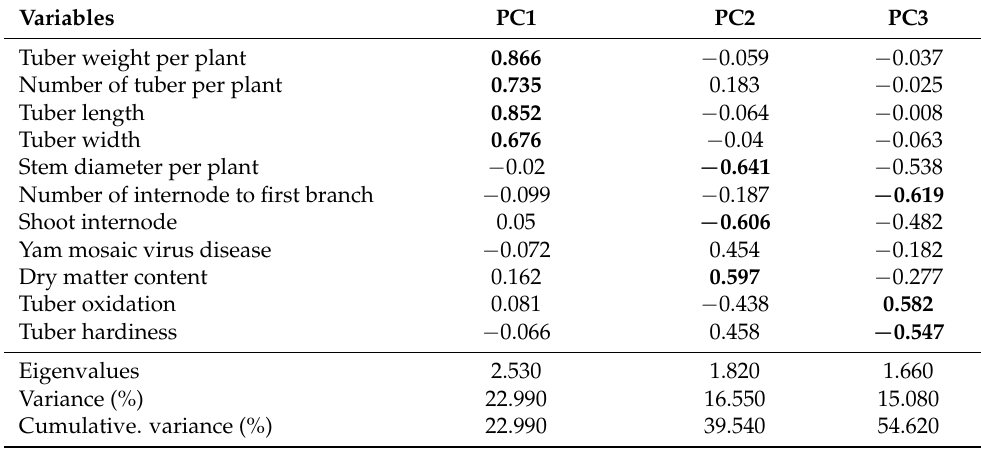
Table 2. Principal components and correlations among quantitative traits of D. praehensilis accessions (Bold values represent traits with high contribution to each